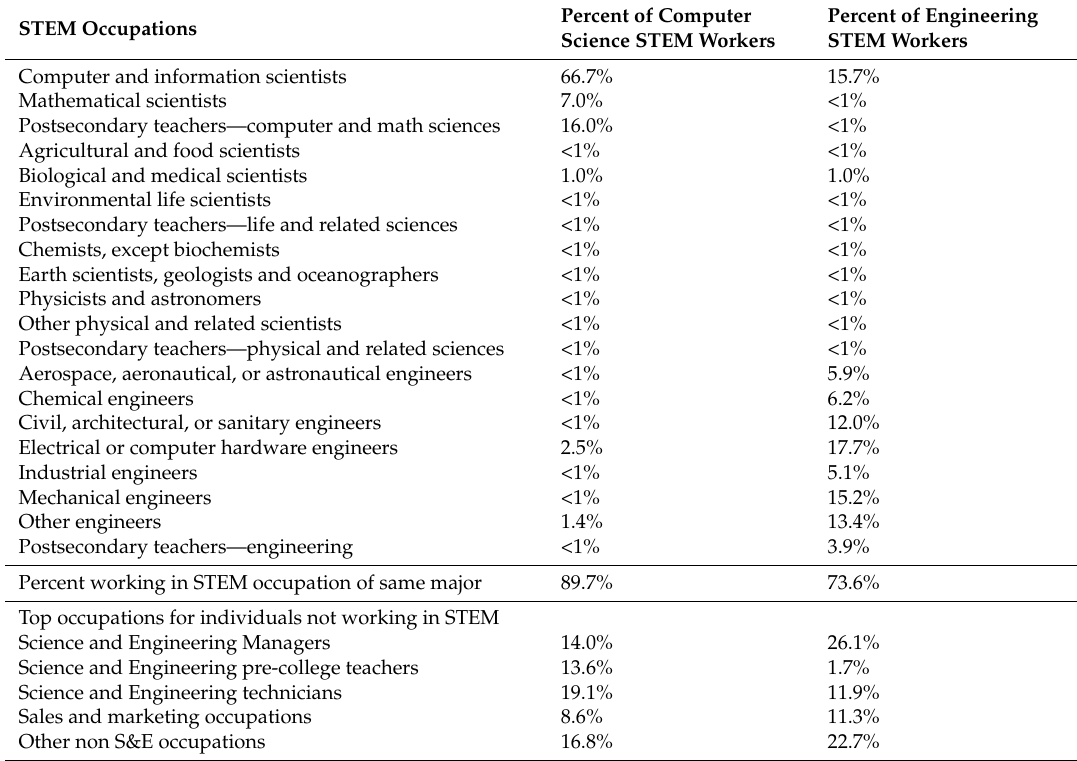
Table A1. List of STEM occupations and the fraction of computer science and engineering STEM workers working in each